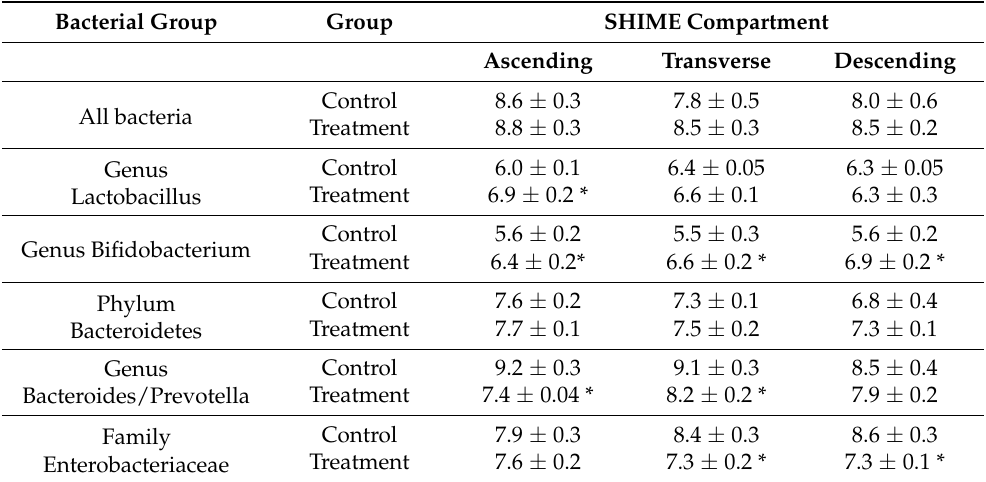
Table 1. Average ( ± SEM) abundance (log CFU mL − 1 ) of microbial groups in SHIME compartments during untreated (control) and treatment with AX microcapsules. Bacterial Group Group SHIME Compartment Ascending Transverse All